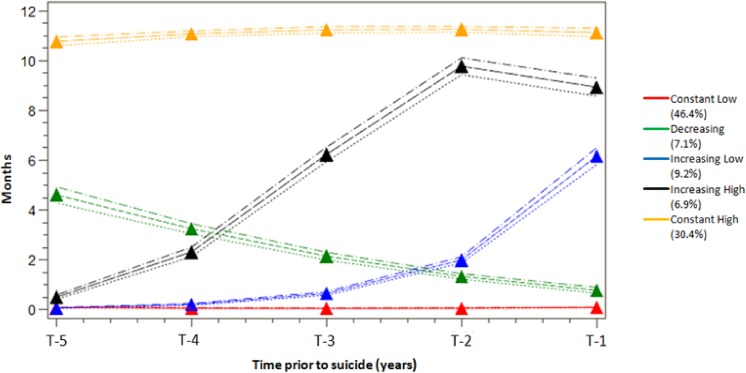
SA/DP trajectories during the five years (T–5 to T–1) prior to suicide, mean number of net SA/DP months per year.The figure displayed five different trajectories of sickness absence and disability pension (SA/DP) five years before suicide. The “Constant Low” group (red line) included individuals (46.4%) who had few month of SA/DP over the year before suicide. The “Constant high” group (yellow line) included 30.4% of the individuals with high level of SA/DP over the years. There were 9.2% of individuals belonged to the “Increasing Low” group (blue line) and 6.9% of individuals belonged to the “Increasing High” group (black line). This two groups revealed increasing of SA/DP with different speeds. The “Decreasing” group (green line) contained 7.1% of the individuals with a decrease in SA/DP over time.